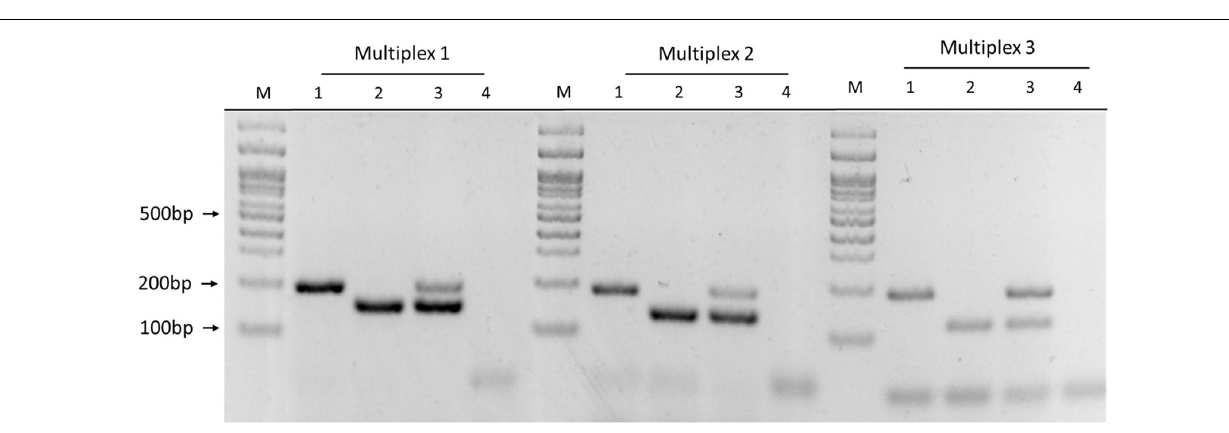
FIGURE 4 | Multiplex PCR prototype using different primer mixes. Multiplex-1: 1755/1207 primer mix; Multiplex-2: 2701/371 primer mix; Multiplex-3: 660/1207 primer mix. Samples: (1) EM-90 strain, (2) LF-89 strain, (3) LF-89 and EM-90 like mix (1:1 ratio), (4) negative control, and (M) Molecular weight marker (100 bp